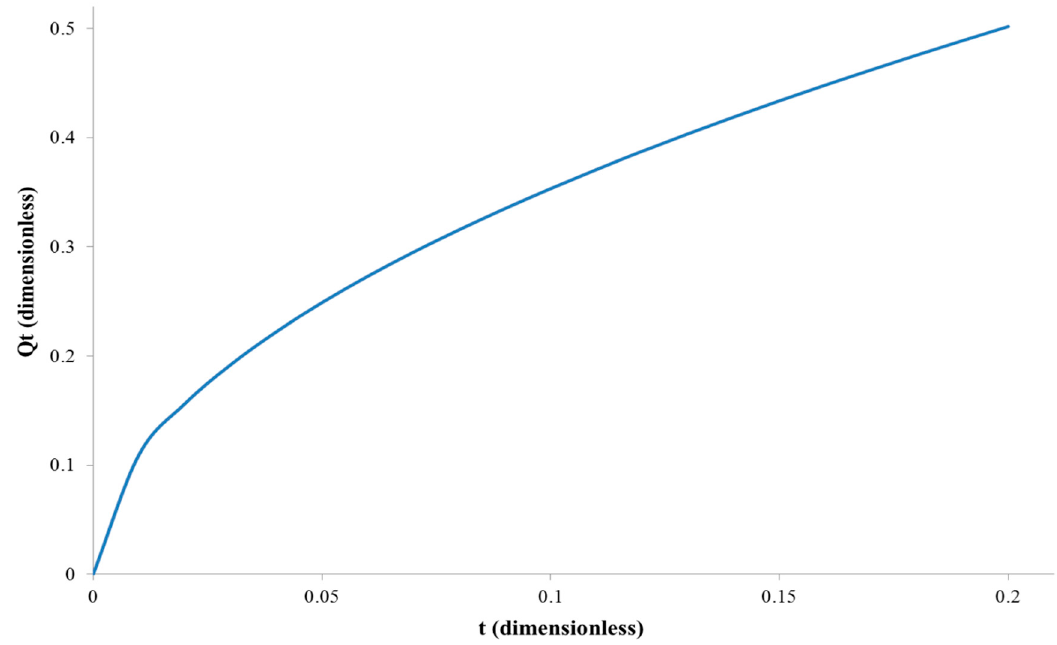
Figure 3. The relation between the total amount of diffusing substance and the time in the case when the membrane is filled with feed solution, i.e., C 0 = C 1.